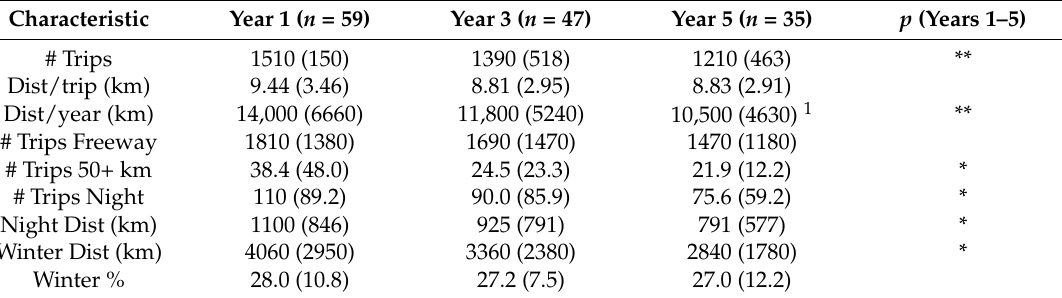
Table 3. Driving characteristics of older drivers over five